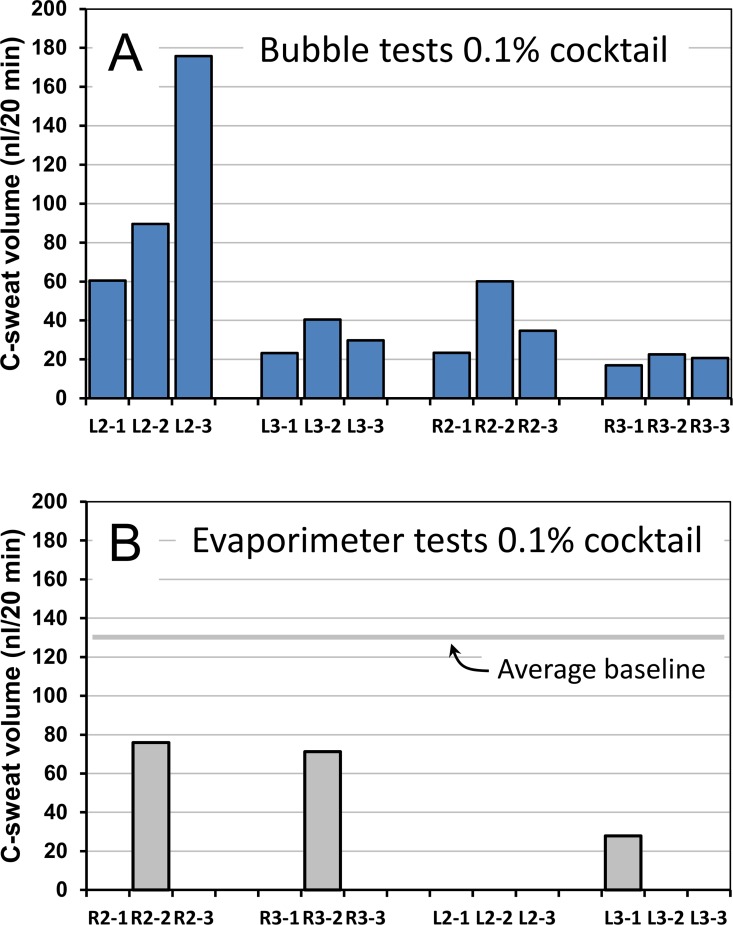
Summary of responses to 0.1% cocktail in a CF carrier measured in triplicate at 4 sites with sweat bubble imaging and evaporimetry.(A) Total volume of sweat imaged after 20 min stimulation at each site (blue columns). (B) Total volume of sweat estimated from evaporimetry measurement of TEWL (see text). The average TEWL baseline for this subject across all 12 tests is shown; this value was subtracted from the transient sweat responses (gray columns).